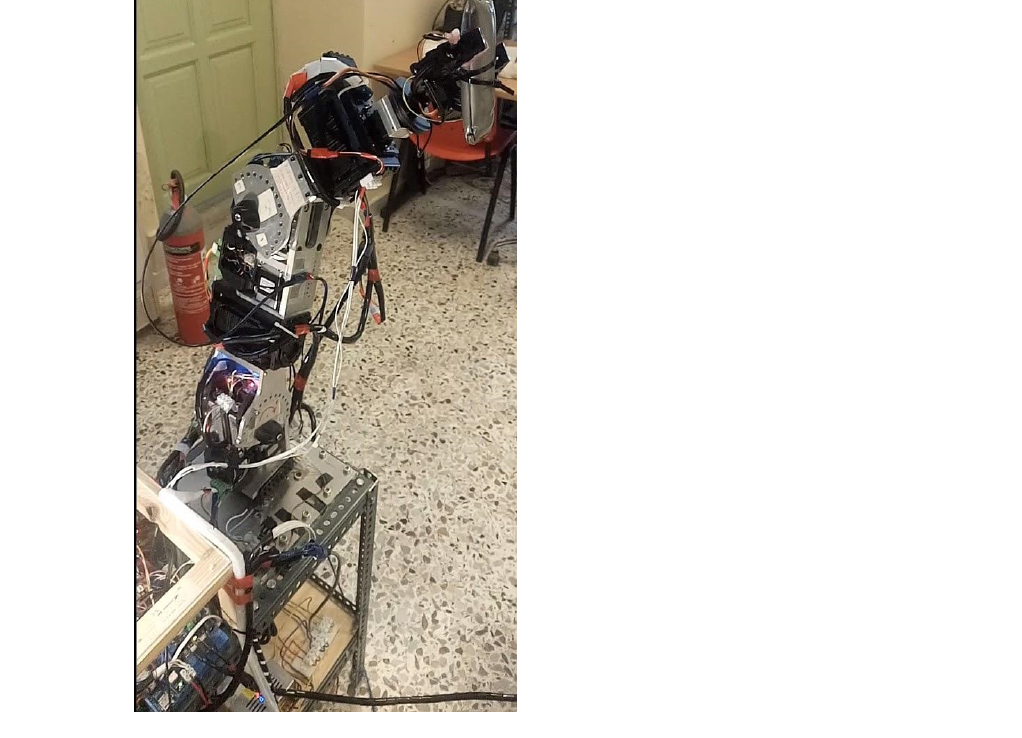
Figure 11. Optimal anatomy of the metamorphic manipulator derived under the effective mass measure for Task 1.